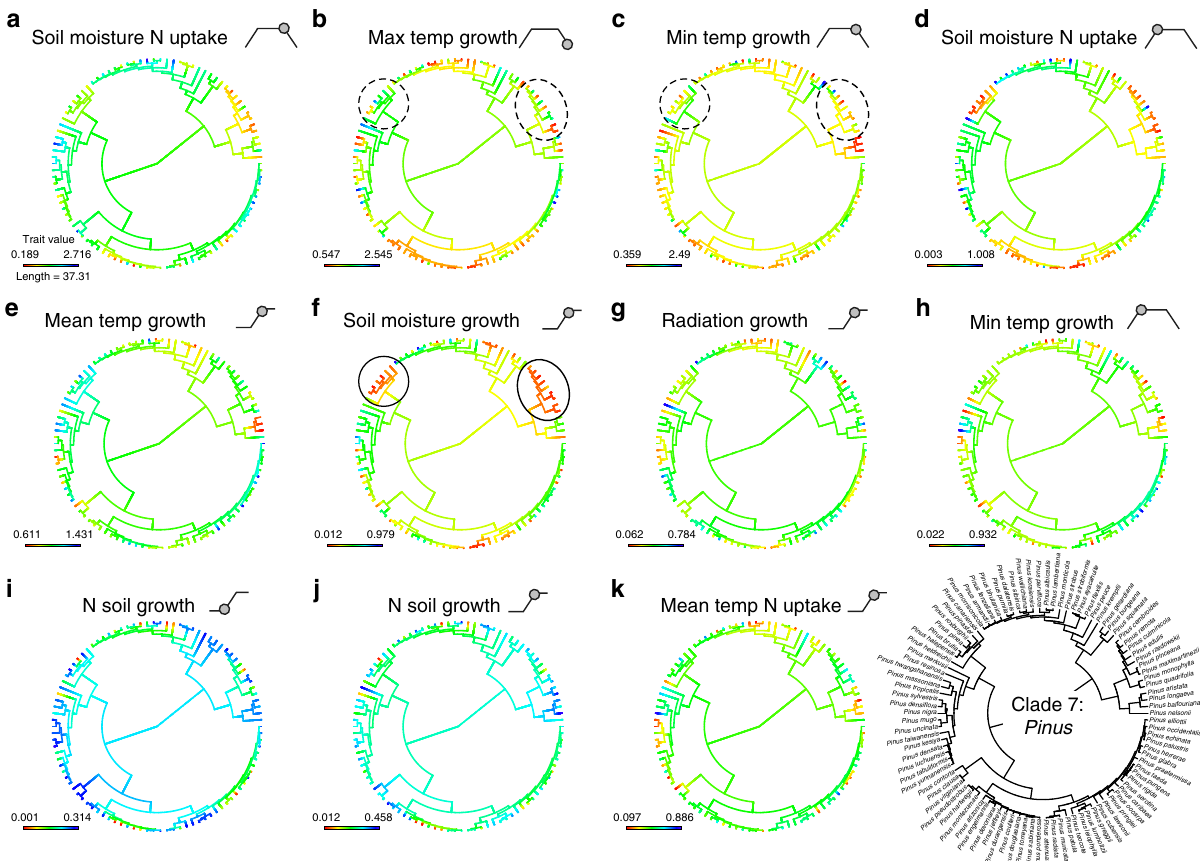
Fig. 6 Niche dimensionality in Pinus . Phylogenies of Clade 7 ( Pinus ) showing ancestral state reconstructions of the 11 most important niche dimensions in order of importance ( a – k ). The bottom right panel shows the same phylogeny with species names. Sub-clades within Pinus with conservative (solid ellipse) and labile (dashed ellipse) niche dimensions are highlighted and discussed in the text (see Results and Discussion). The fi lled circle on trapezoid and step diagrams beside the trait names, show how the trait relates to the modelled growth or resource acquisition function. For example, ( a ) is the point at which soil moisture causes a reduction in N uptake, that is, when waterlogging reduces N